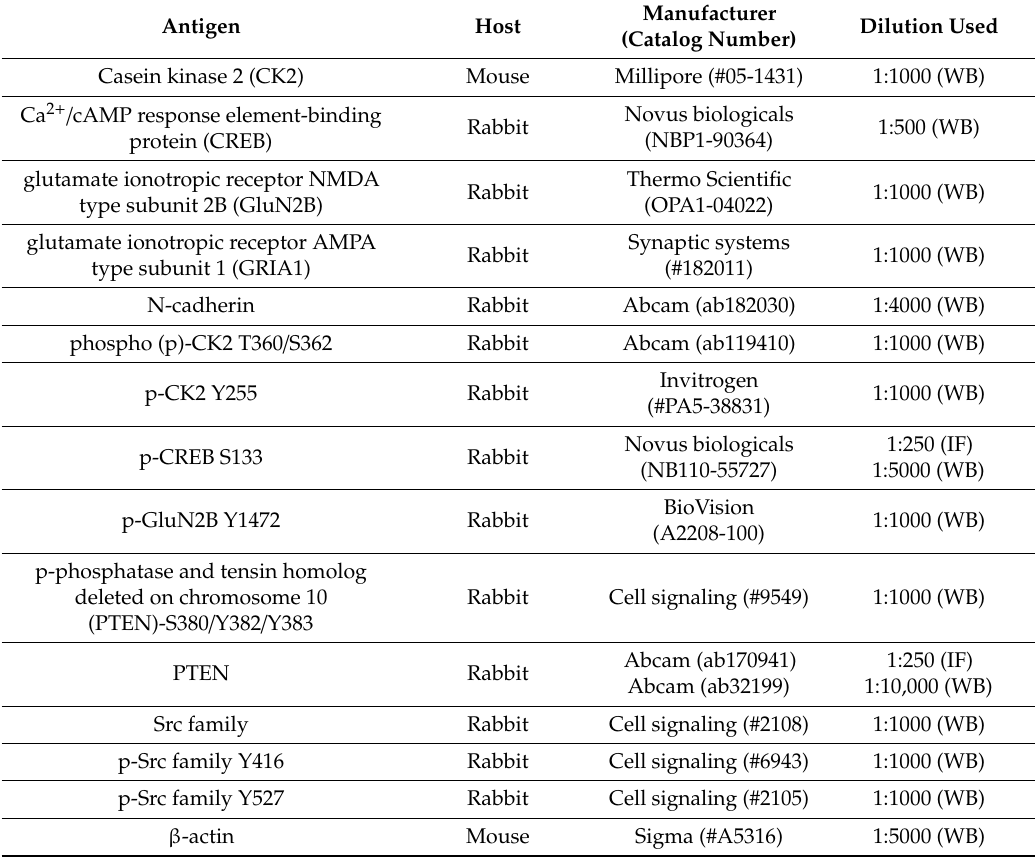
Table 1. Primary antibodies used in the present